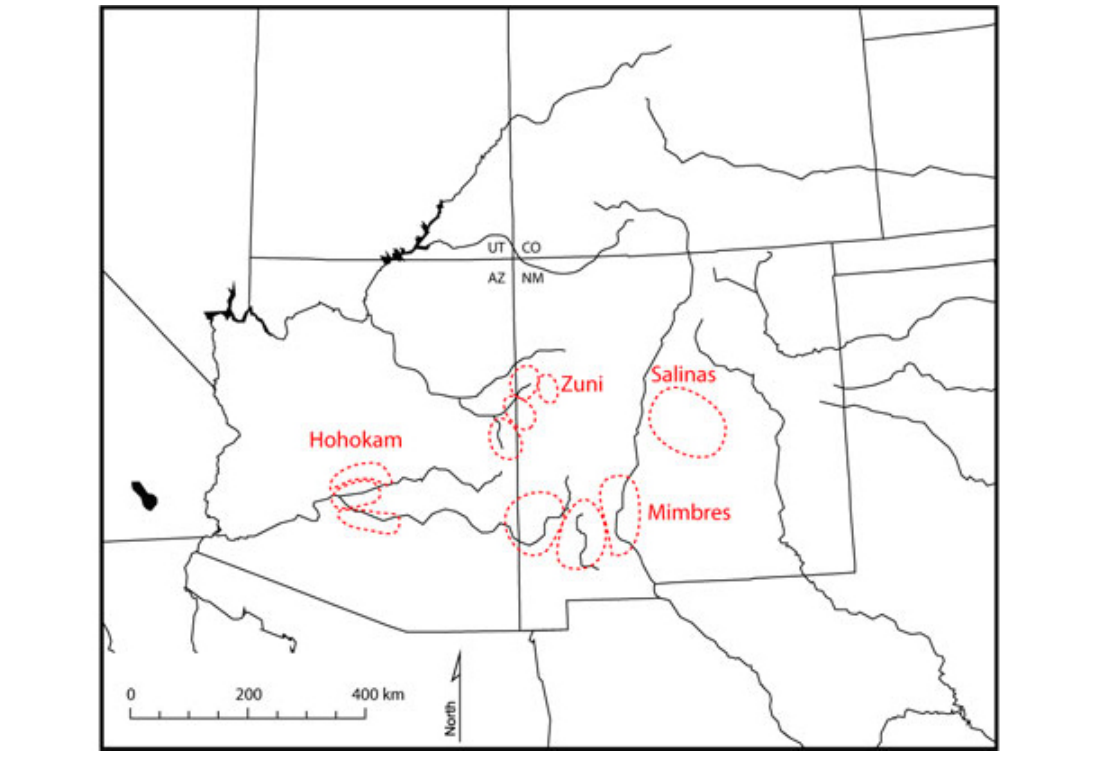
Fig. 6 . Map of the U.S. Southwest showing four regions and all subregions used in this